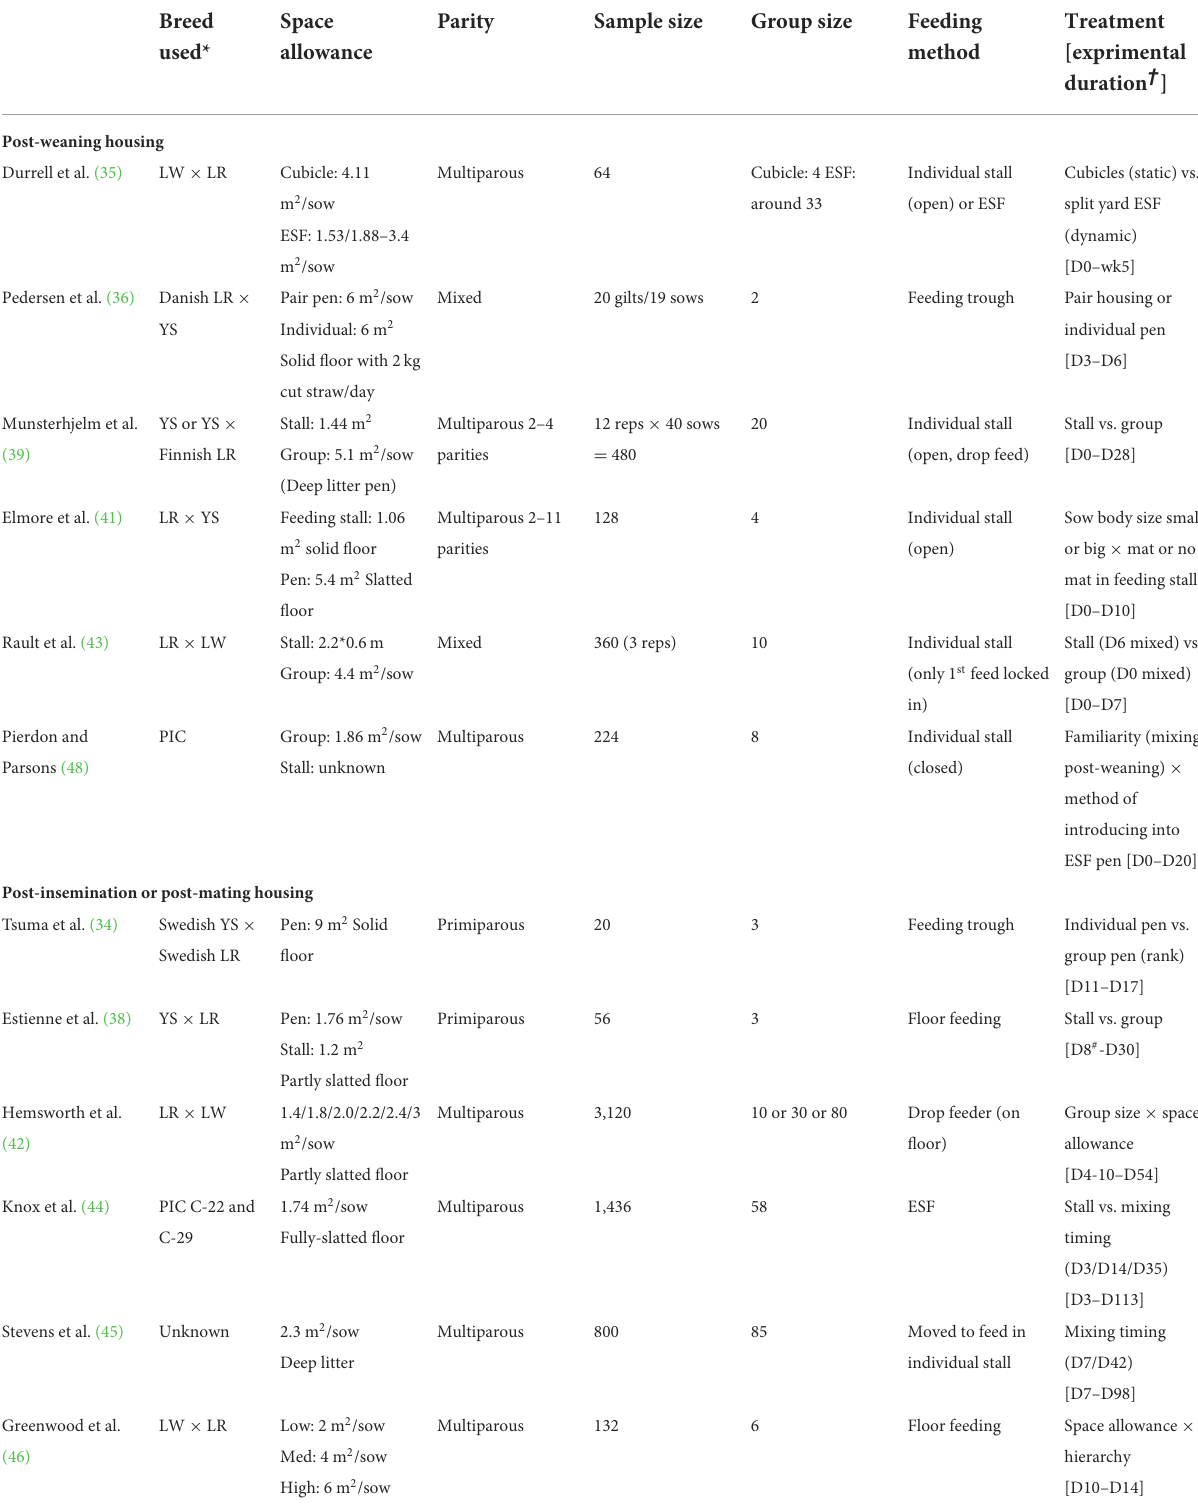
TABLE 3 List of experimental studies for